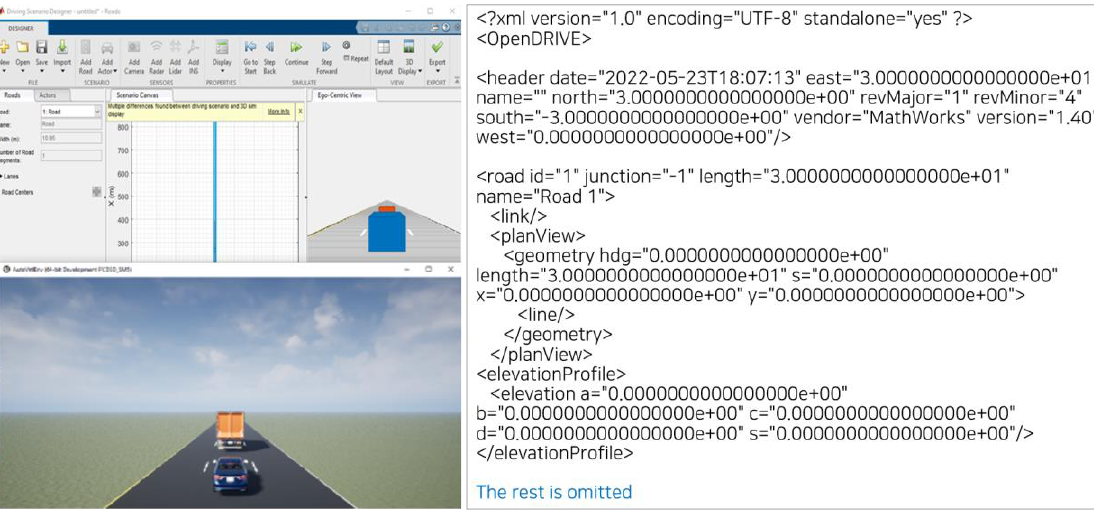
Figure 6. Test case generation